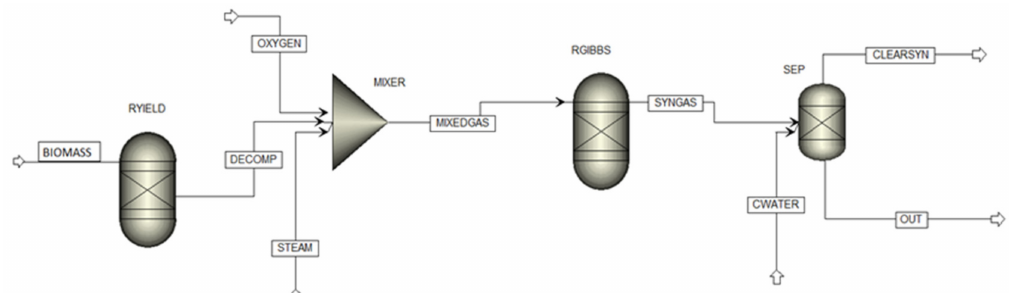
Figure 6. Aspen Plus flow sheet of (oxygen + steam) FBG